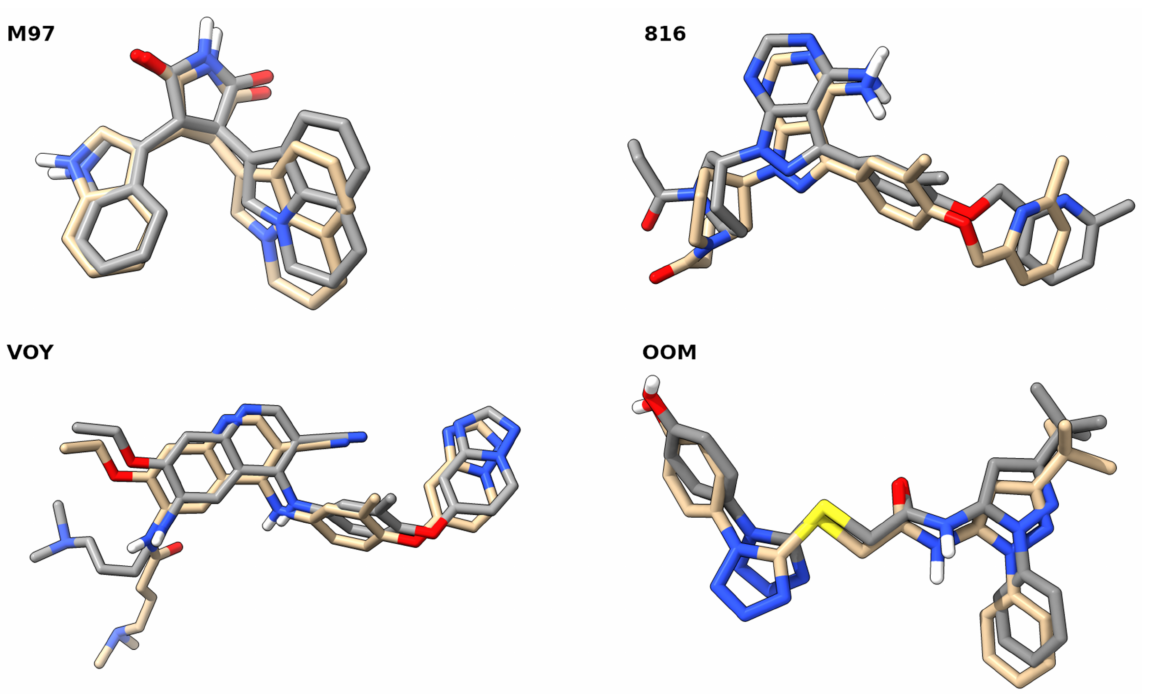
Figure 8. Superimposed structures obtained in re-docking experiment. M97, 816, VOY and OOM ligands where co-crystallized with the cMet (PDB code: 3RHK), EGFR (PDB code: 5GTY), HER2 (PDB code: 7JXH), hTrkA (PDB code: 6PL2), respectively. Color coding: beige—carbon atoms of the co-crystallized structures, grey—carbon atoms of the re-docked structures, blue—nitrogen, red—oxygen, yellow—sulfur, white—hydrogen. All-atom RMSD values are as follows: 0.832, 1.812, 2.006, 1.200 for M97, 816, VOY and OOM, respectively. Table 2. Binding affinities of the investigated ligand-receptor complexes. Values given in kcal/mol. Compound cMET EGRF